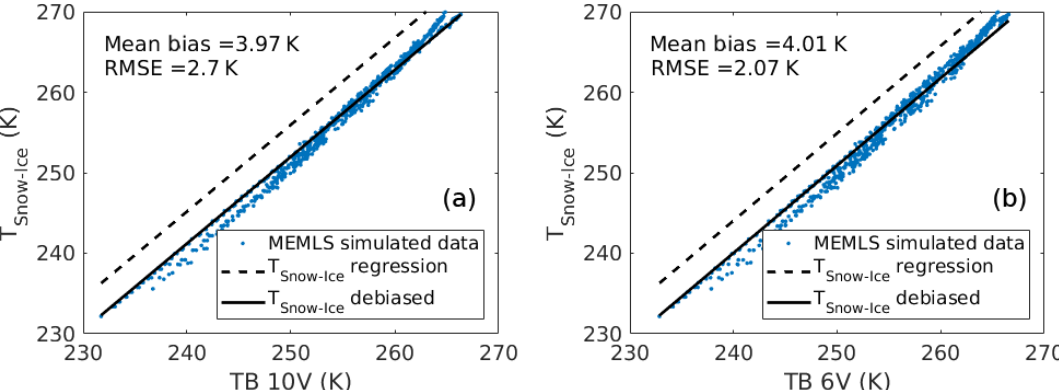
Figure 10. Comparisons between the T Snow-Ice MEMLS from the MEMLS-simulated data is shown with blue points, the regressed T Snow − Ice (Eqs. 5 and 6) with a dashed black line, and the regressed T Snow − Ice debiased to fit the MEMLS simulations with a solid black line at 10V (a) and 6V (b) channels.